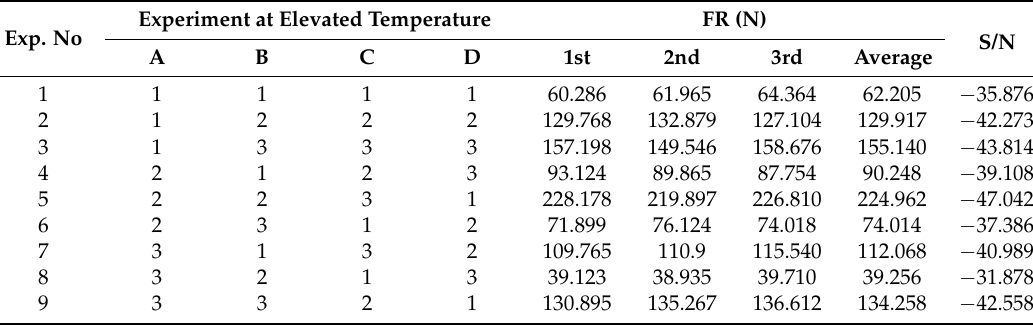
Table 7. Results of the cutting force (F T ) and S/N ratios at elevated